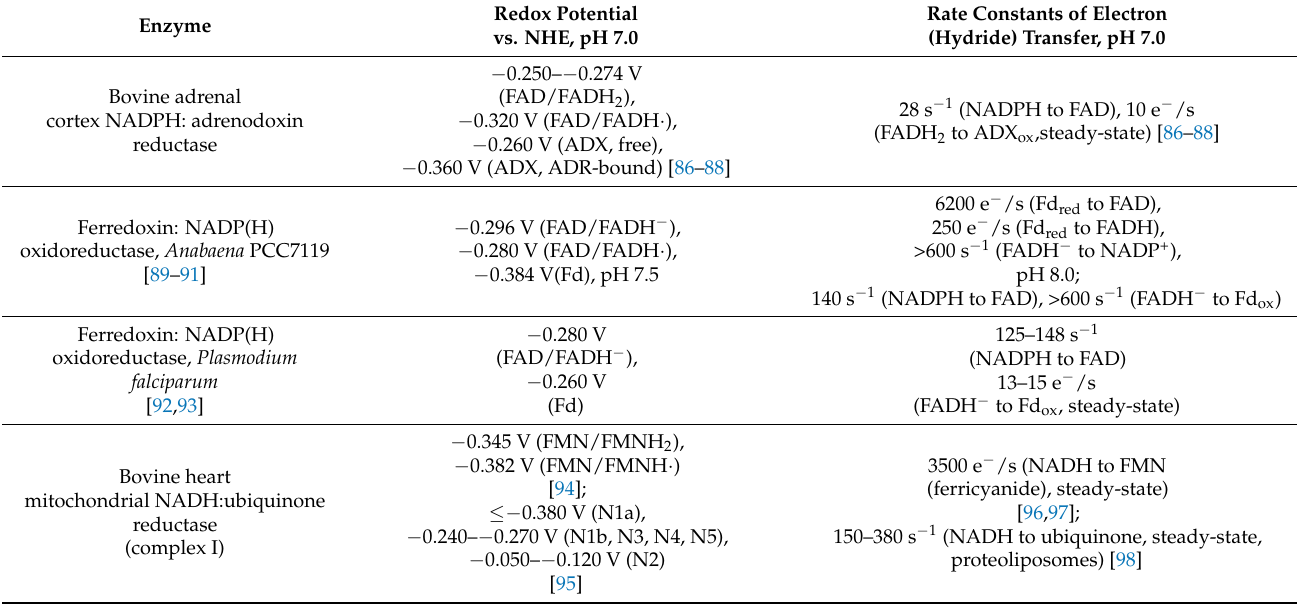
Rate Constants of Electron (Hydride) Transfer, pH 7.0